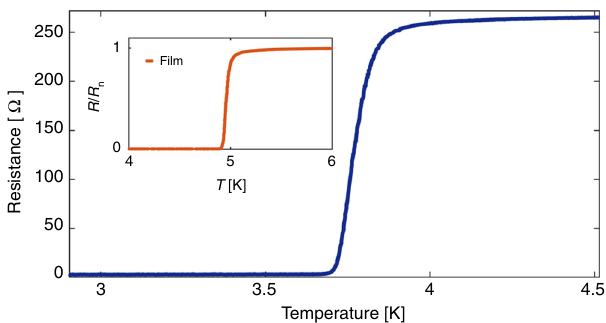
Fig. 3 Temperature dependence of the resistance of a Nb-coated superlattice. The superconducting transition T c ~ 3.8 K at zero fi eld. Inset: Resistance versus temperature at zero fi eld for the reference sample, a 10 nm thick Nb fi lm; T c ~ 5 K. are clearly observed in the I – V characteristics. These variations imply that the array approaches the full normal state gradually, re fl ecting a distribution of the Josephson critical currents in the superlattice sample. The onset of a voltage at I c indicates that in every possible path of the current there is at least one Josephson junction, which is in the voltage state. The fact that the variations in the current are small, indicates that actually the majority of the array ’ s junctions in most of the current paths are in the voltage